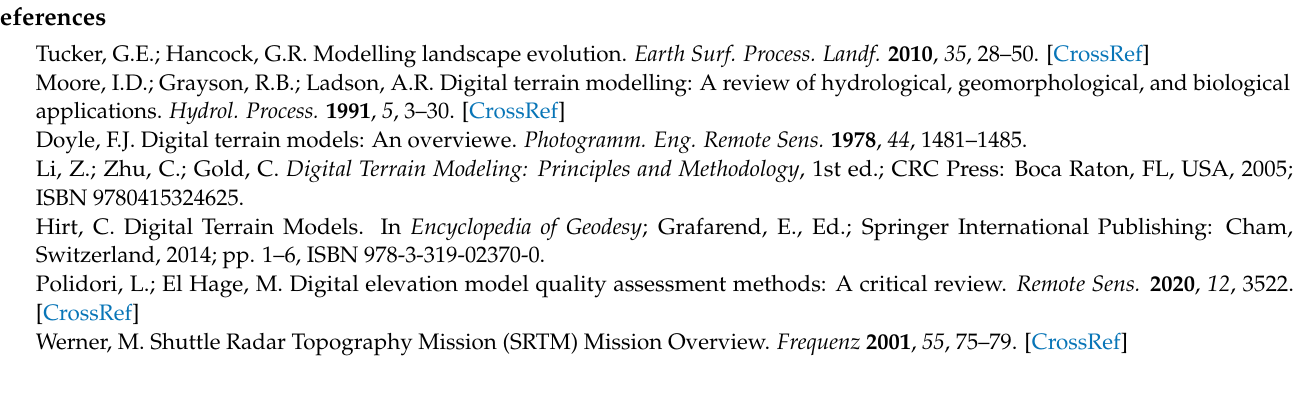
shown in Figure 3 is indicated as the red box, Table S1: Land cover classes and descriptions from Naturvårdsverket